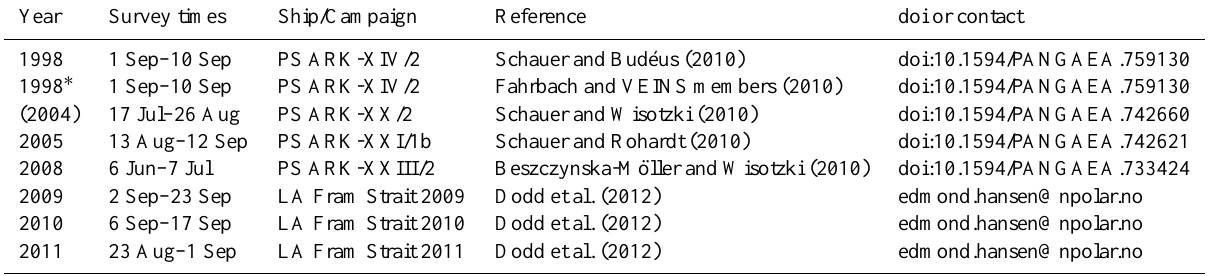
Entries marked with ∗ refer to nitrate, phosphate and δ 18 O water sample measurements, all others denote temperature and salinity (CTD) profiles. Ship abbreviations are as follows: PS=R/V Polarstern ; LA=R/V Lance .